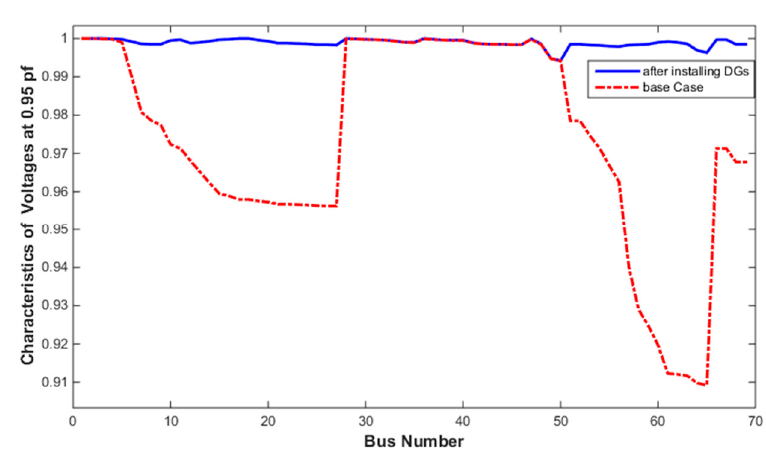
Figure 23. Characteristics of power loss at 0.95 pf.